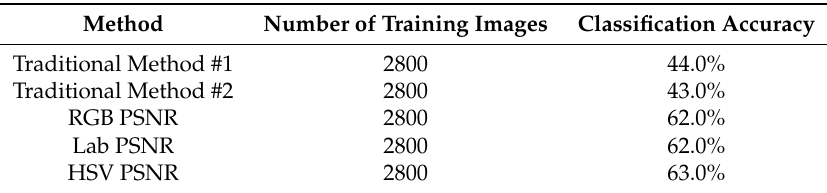
Table 2. Classification accuracy of traditional methods and the methods that use the inverse PSNR, with an equal number of training images.